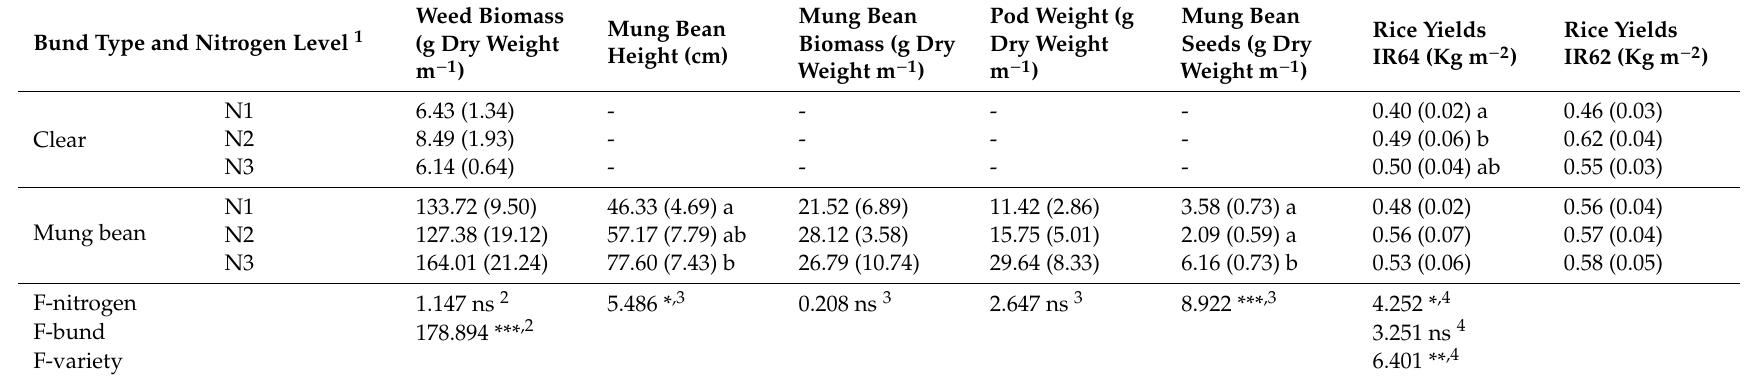
Table 2. Details of bund vegetation during the 2013 wet season crop and corresponding yields in adjacent plots of IR62 and IR64 rice. Bund Type and Nitrogen Level